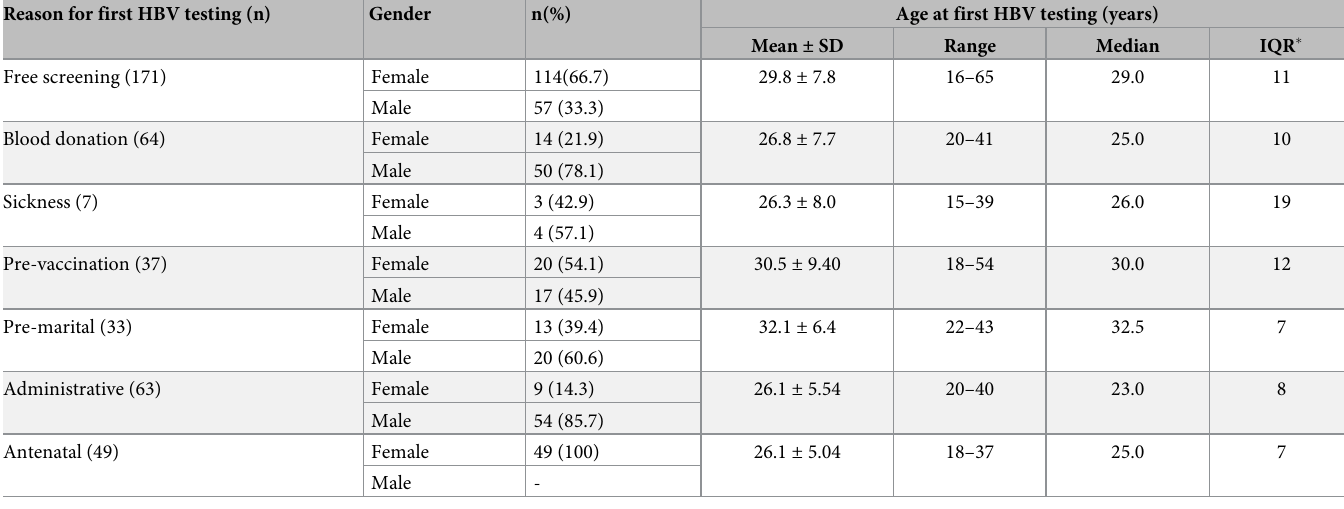
Fig 1. Reasons for first ever HBV testing for all participants (n = 424). https://doi.org/10.1371/journal.pgph.0000321.g001 Table 4. Distribution of gender and age at first HBV testing across various testing